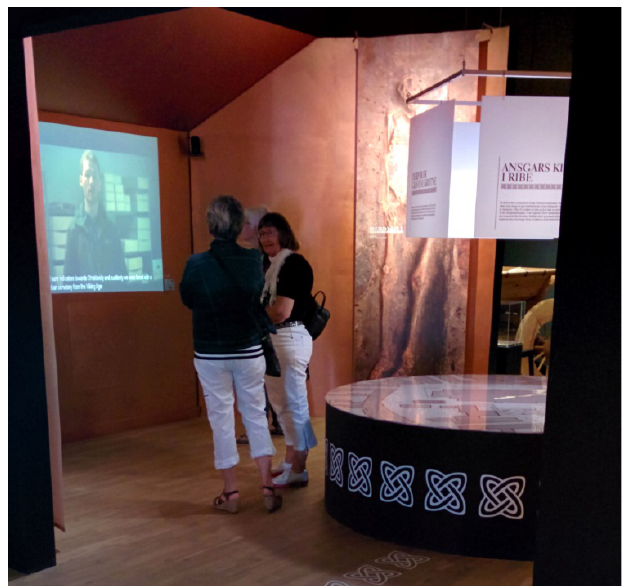
Figure 14. A social audio-visual media experience. Museet Ribes Vikinger, Denmark. Photo: The author.